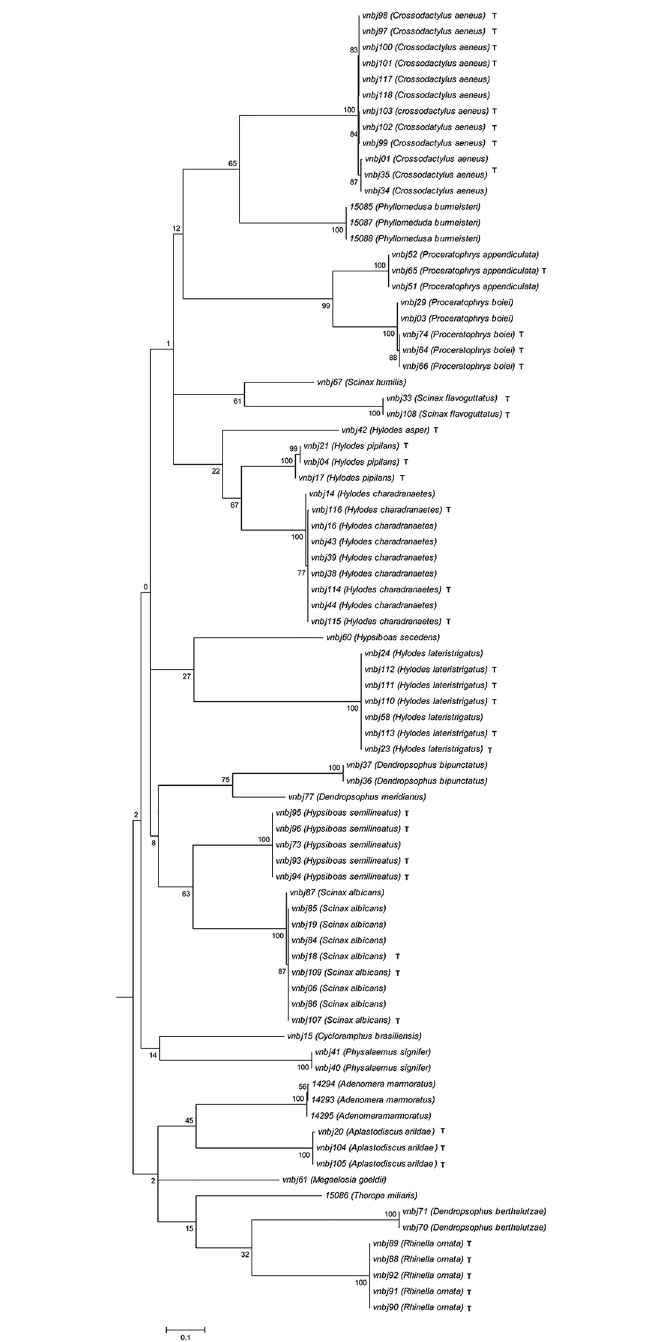
Fig 3. Neighbor-joining (K2P) tree of the COI gene. Bootstrap probabilities near each internal node. Tadpoles are marked with a T after the species epithet. All remaining specimens comprise adults from the reference database.